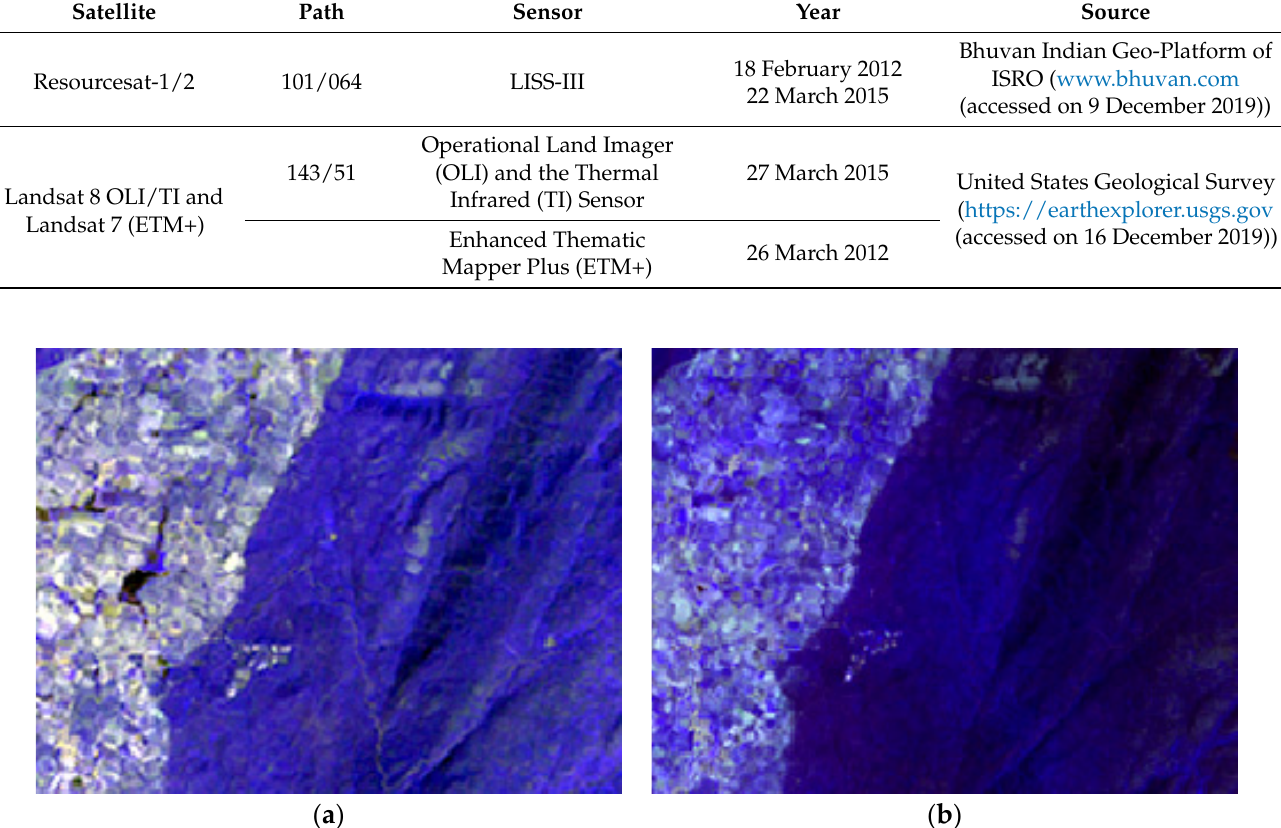
Figure 2. Preprocessed LISS-III multispectral image of Javadi Hill for the years ( a ) 2012 and ( b ) 2015.